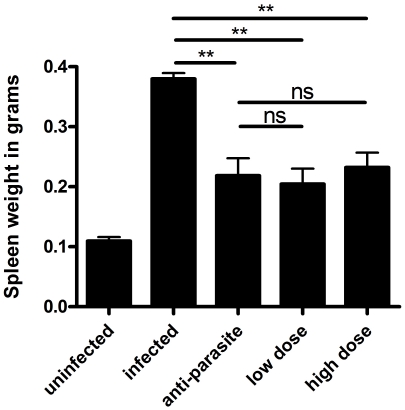
Spleen weights were not changed after Anti-fibrosis treatment with low dose or high dose prizaquantel compared with anti-parasite treatment in mice 15 weeks post infection with Schistosoma japonicum.Spleen weights were reduced in anti-parasite, anti-fibrosis low dose and high dose groups compared with infected group, but no significant changes were found between treated groups. (** p<0.01).